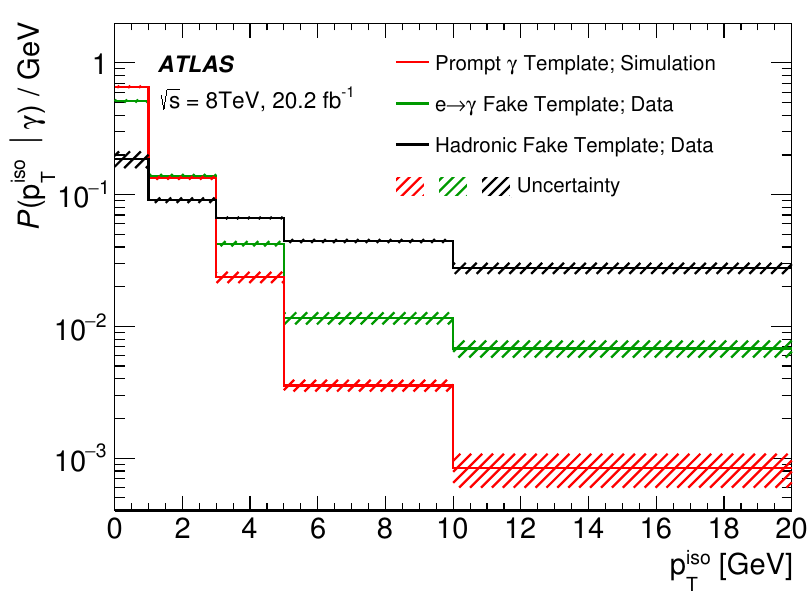
Figure 2. The p iso templates for the inclusive cross-section measurement for prompt photons, T hadronic fakes and electron fakes. The template for the signal photon is taken from simulation, while the other two templates are derived from data. The distributions are normalised to unity and the last bins contain the over(cid:13)ows. The shaded bands show the total uncertainty in each